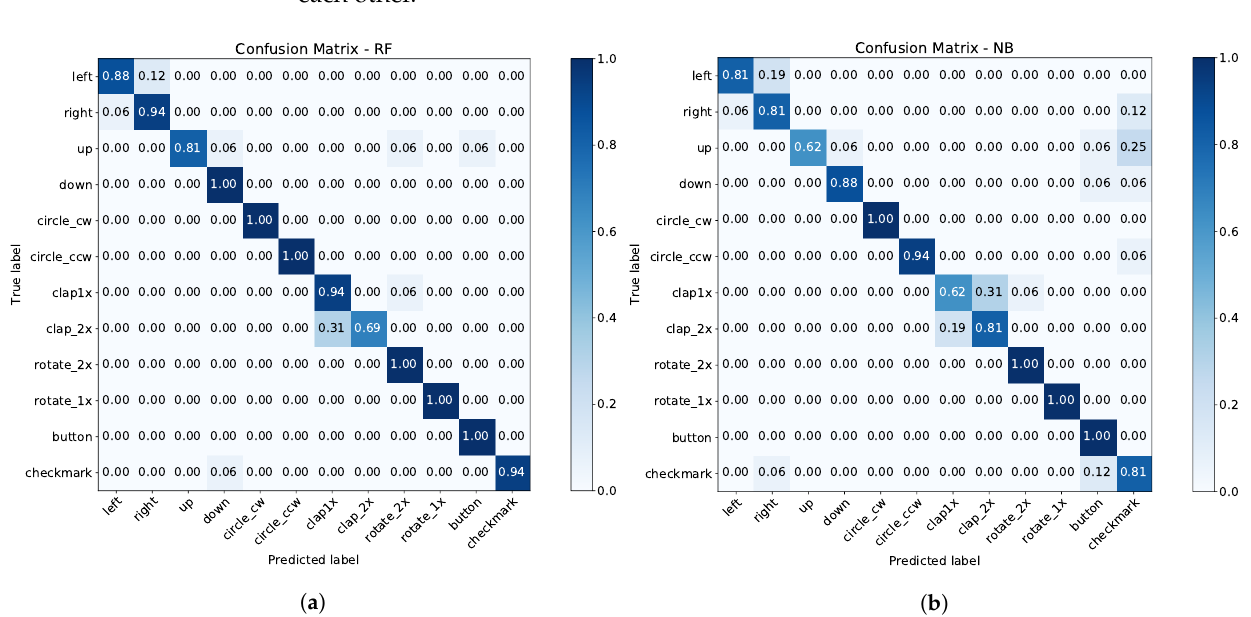
Figure 18. Confusion matrices illustrating results. ( a ) Confusion matrix for the best performing model trained by the ring data set of the ring session. The RF model achieved an accuracy of 93.2%, while utilizing the medium sized feature vector. ( b ) Confusion matrix for the worst performing model representative trained by the ring data set of the ring session. The NB model achieved an accuracy of 85.9%, while utilizing the medium sized feature